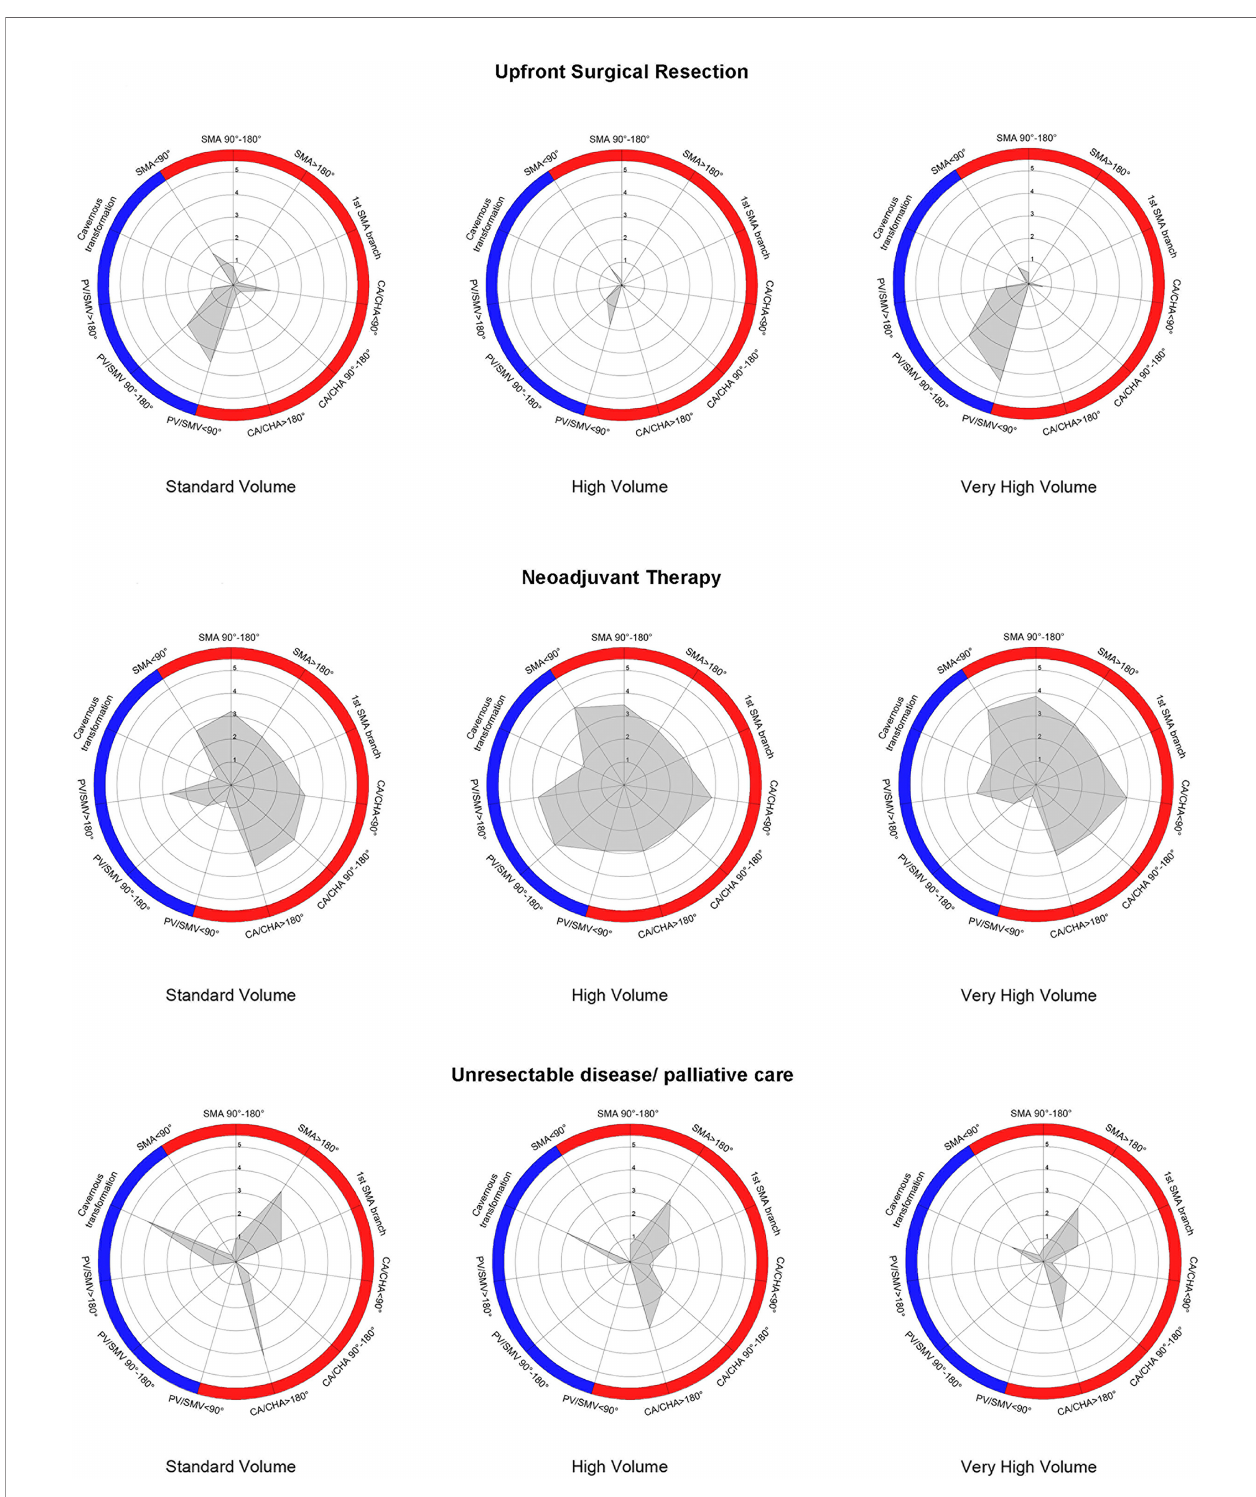
FIGURE 1 | Radar chart depiction of upfront surgical resection, utilisation of neoadjuvant treatment, and declaration of unresectability in initial PDAC diagnosis based on variable vessel involvement by the primary tumour between the three volume-related tiers. Blue-coloured and red-coloured areas indicate different degrees of venous and arterial involvement, respectively; 1-5 enumeration refers to percentage of responses (1 = 20%, 5 =